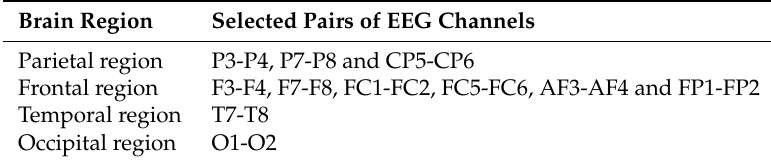
Table 4. The brain regions covered by the selected 11 pairs of EEG channels.